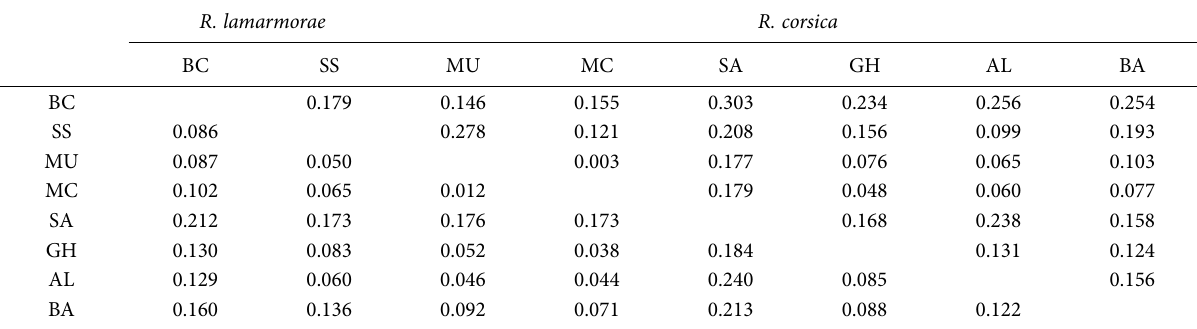
Table 4. Pairwise population estimates of F ST (diagonal below) and D est (above diagonal). All values are statistically significant (95% CI). For abbreviations of populations see Table 1.